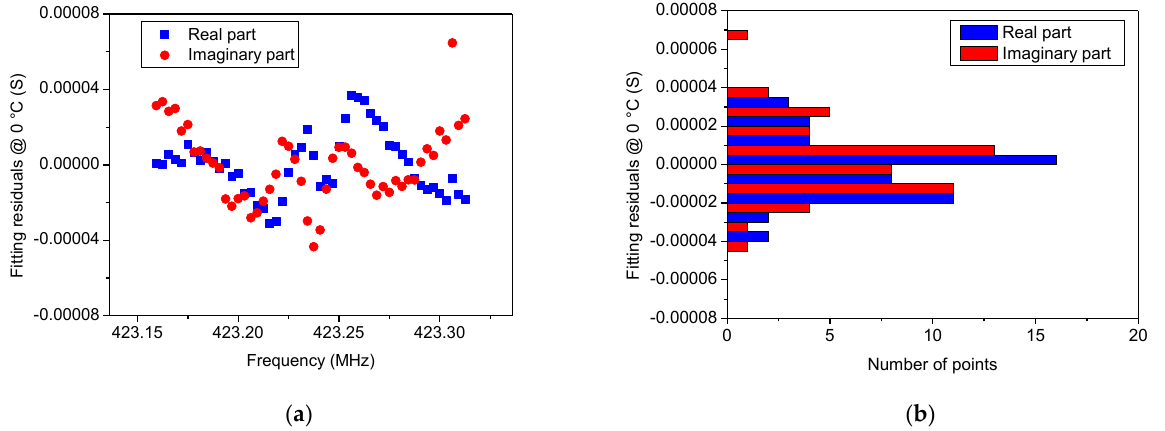
Figure 6. ( a ) Residuals of the Lorentzian fitting at 0 °C and ( b ) their probability distribution function that can be considered normal, thereby providing proof of good fitting.